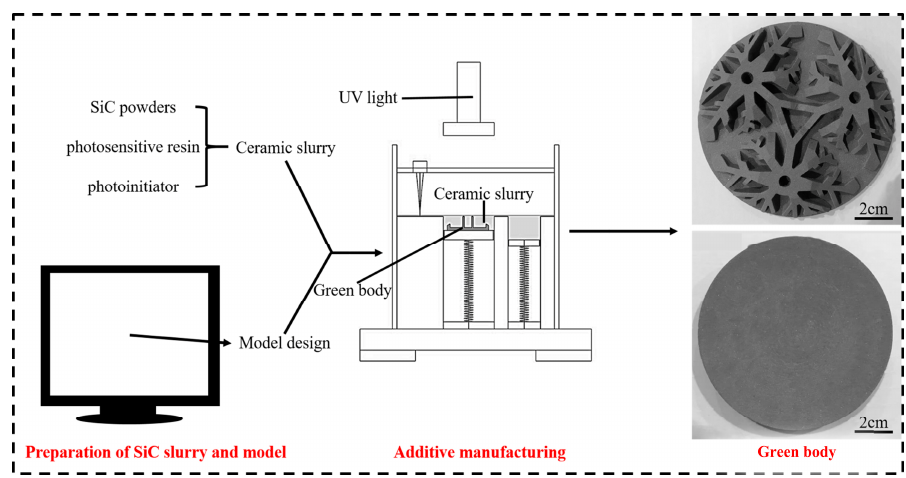
Figure 1. Preparation process of topological structure SiC ceramics.